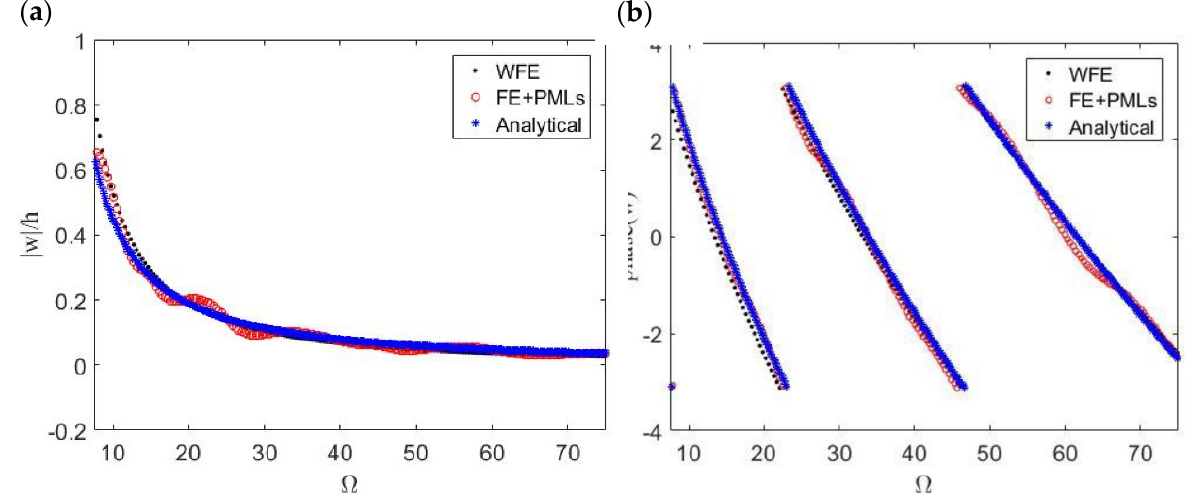
Figure 3. Response of a thin plate excited by a harmonic transverse point force, ( a ) absolute value; ( b ) phase. Comparison between the approximated WFE, FE model with PMLs and analytical results.